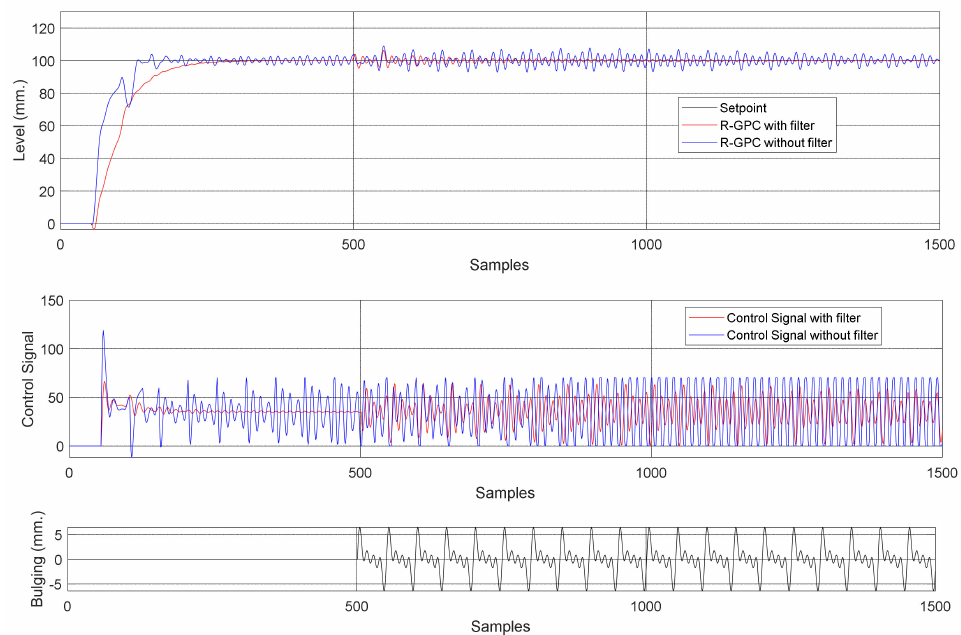
Figure 16. Comparison among the repetitive structures with filter (red) and without filter (blue) and the bulging